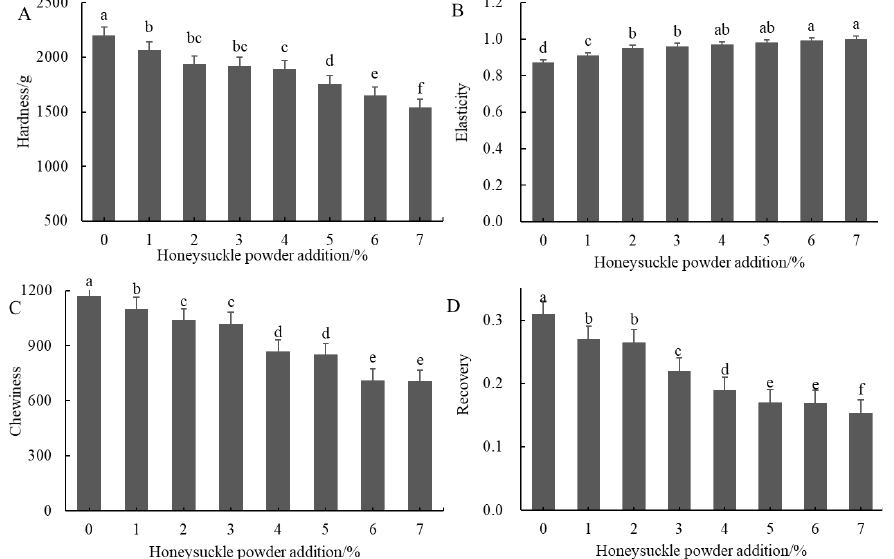
Figure 2. The effect of the honeysuckle powder on the texture characteristics of the bread. Note: ( A ) is the hardness, ( B ) is the elasticity, ( C ) is the chewiness, and ( D ) is the recovery. Different lowercase letters in the same column indicate a significant difference ( p < 0.05), while the same lowercase letters indicate no significant difference ( p > 0.05).